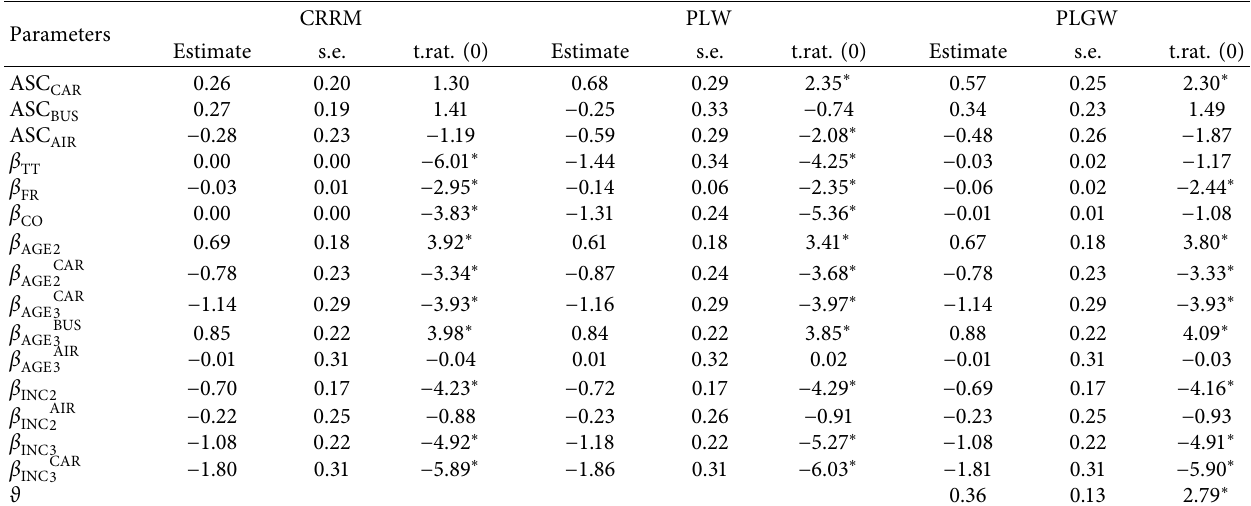
Table 8: Estimates of the CRRM, PLW, and PLGW for business purpose of the HSR